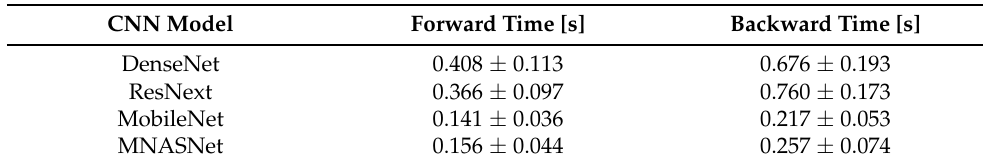
Table 2. Mean time and standard deviation of forward and backward cycle times during training using the setup described in Section